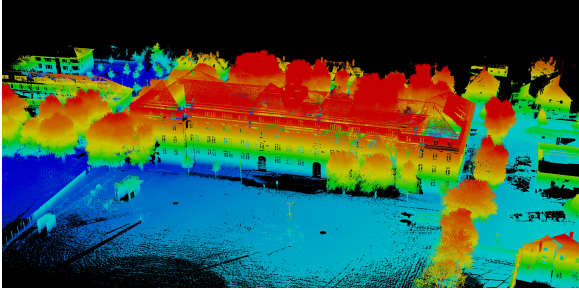
Figure 6. Multiple coregistrated TLS scans.